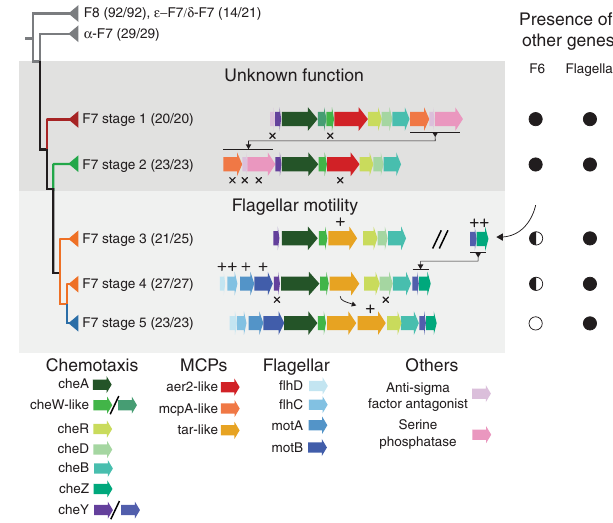
Fig. 3 Major events in the evolutionary history of the F7 system in γ - Proteobacteria. Each major branch is identi fi ed by the type of its F7 system, and shading indicates the function of the system. Numbers in parentheses indicate the number of genomes from the designated class compared to the number of genomes present in the branch. Differences in these numbers indicate lateral gene transfers and are highlighted in Supplementary Fig. 1. The double division symbol is used to show that the protein clusters on each side of the symbol are located in different parts of the genome, the symbols plus and crosses indicate gene additions and losses, respectively. The presence and absence of other relevant systems in the genomes containing each stage are marked as complete (full circle), partial (half circle), or absent (empty